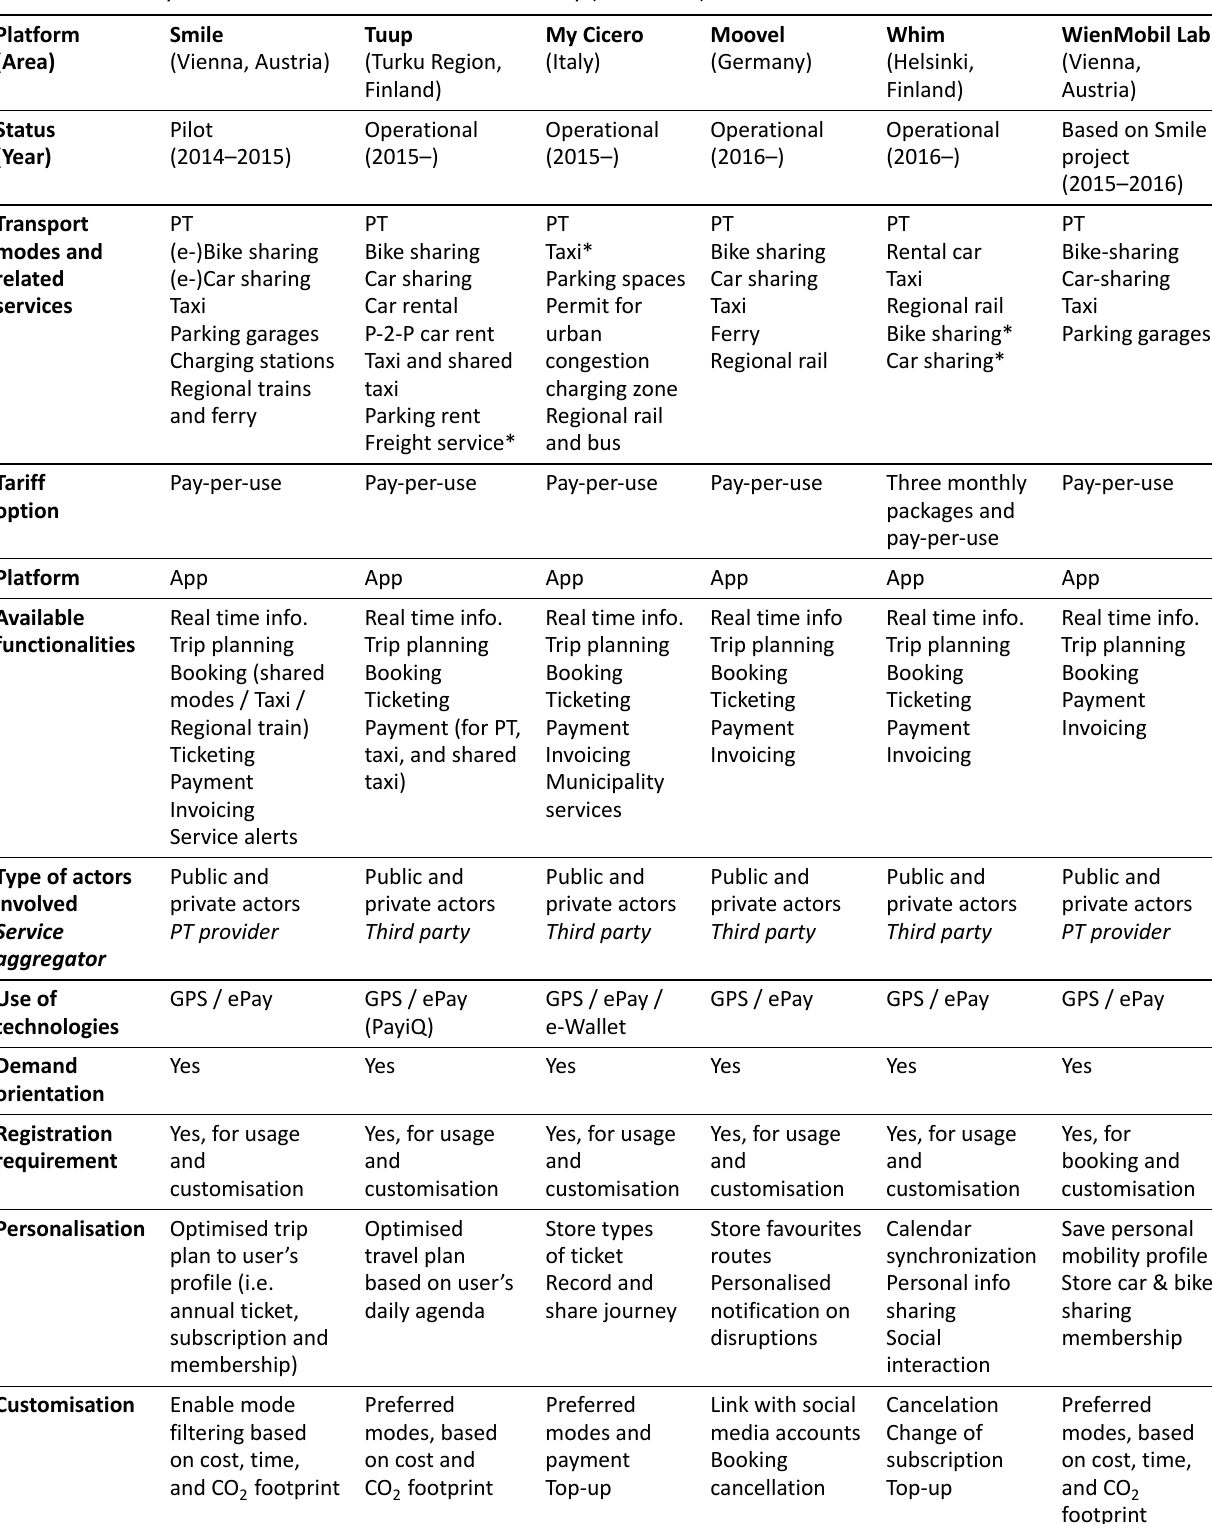
Table 2. Summary of MaaS schemes reviewed in this study (continued). Platform